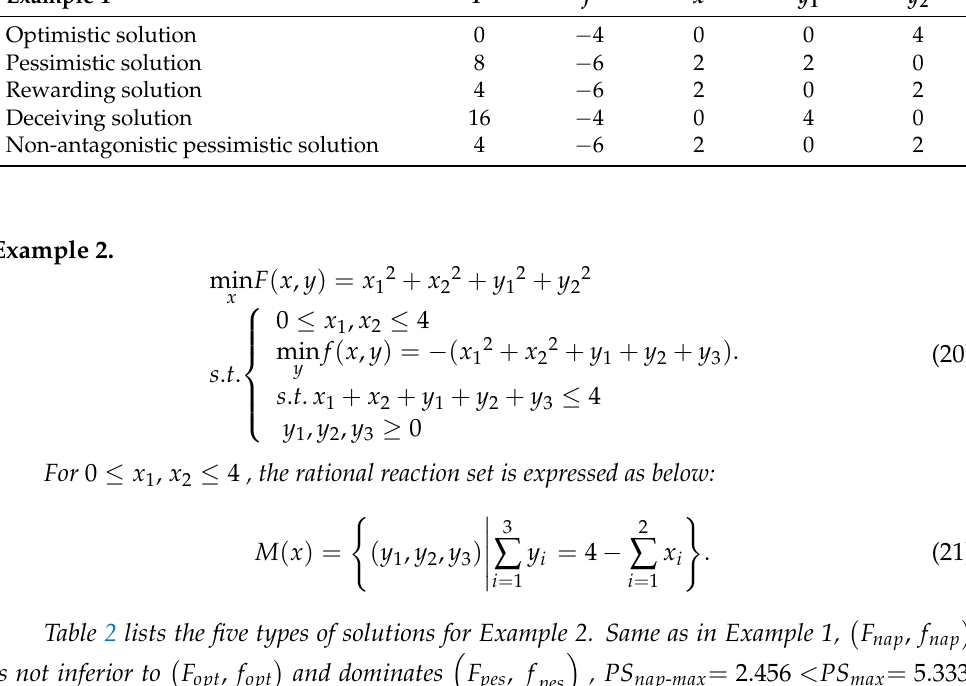
Figure 2. The values of optimal solutions in the upper-level value space of Example 1.